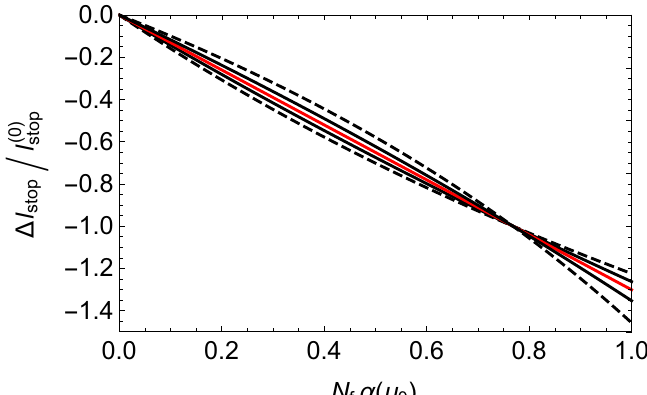
Figure 6 . The relative size (cid:1) ‘ stop =‘ (0) of the NLO correction in large- N f QED to charge stopping stop length ‘ charge , versus N f (cid:11) ( (cid:22) 0 ) for (cid:22) 0 (cid:17) (^ qE ) 1 = 4 . The di(cid:11)erent lines correspond to di(cid:11)erent choices stop MS ( (cid:22) 0 = 5, (cid:22) 0 = 2, (cid:22) 0 , 2 (cid:22) 0 , 5 (cid:22) 0 ) of the renormalization scale (cid:22) used in the calculation of (cid:1) ‘ stop =‘ (0)